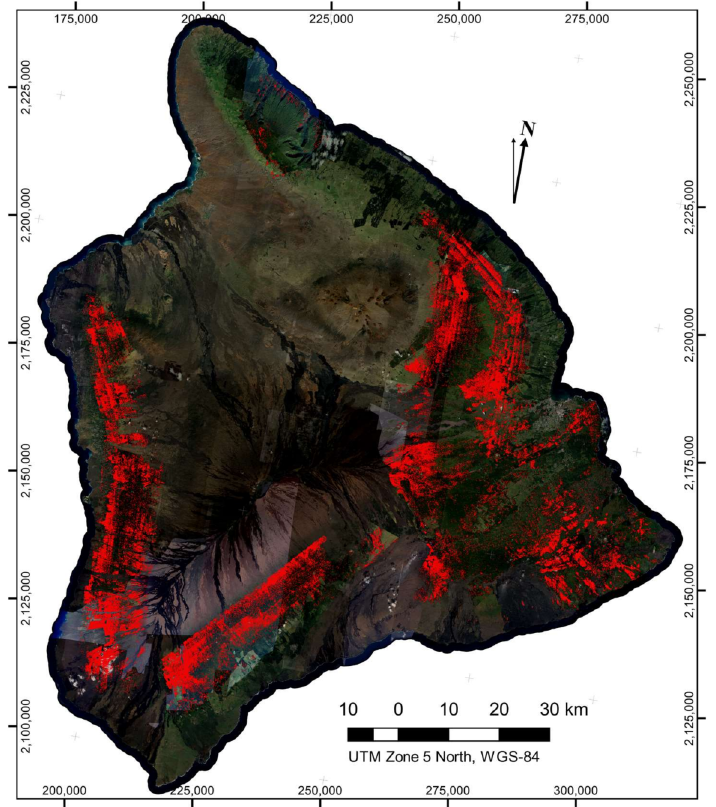
Figure 6. Map of the leafless tree crowns detected using our modeling and filtering approach applied to the CAO coverage of Hawaii in June 2017. Individual points represent single detections of 8 m 2 or greater. For visibility, individual points are 50 m in diameter at this map scale. Therefore, denser clusters of detected crowns appear as contiguous regions on the map. Background imagery from Google, DigitalGlobe